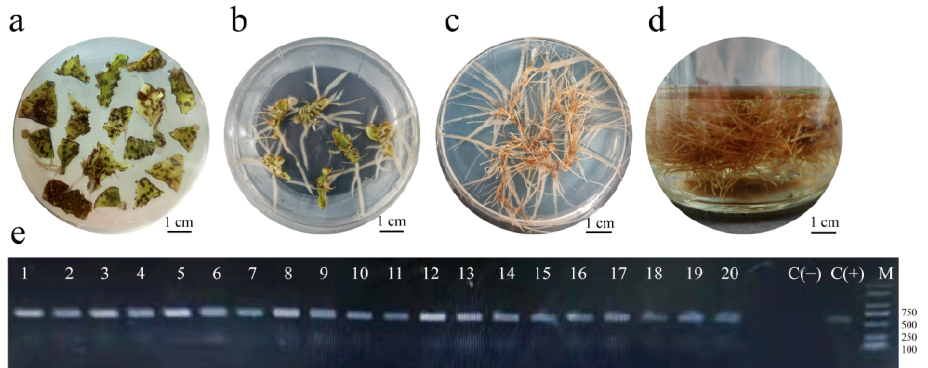
Figure 1. A. rhizogenes Ar Qual-mediated hairy roots culture. ( a ) Root bulges were formed after the infection of A. rhizogenes Ar Qual. ( b ) Hairy roots were formed after the infection of A. rhizogenes Ar Qual. ( c ) Solid culture of hairy roots. ( d ) Liquid culture of hairy roots. ( e ) PCR analysis of the Rol B gene in the hairy root lines of T. hemsleyanum [lane M, marker; L1–L20, the hairy roots lines induced by A. rhizogenes Ar Qual; C(+), plasmid DNA from A. rhizogenes Ar Qual (positive control); C( − ), roots from a non-transformed control plant (negative control)]. Under the same conditions, A. rhizogenes Ar Qual harboring the binary vector pCAMBIA 1381Z (CAMBIA)—which contains GUS ORF and the selective marker gene kanamycin resistance (KAN) under the control of CaMV35S promoter—successfully in- fected the leaf to induce hairy roots for system stability and genetic transformation veri fi - cation (Figure 2a–d). The PCR primers Rol B and KAN were used to identify hairy roots (Figure 2e,f). Meanwhile, blue color was observed on the hairy roots transformed with the Ar Qual strain carrying pCAMBIA 1381Z and no color was observed on the Ar Qual wild- type strain-transformed hairy roots (Figure 2g).